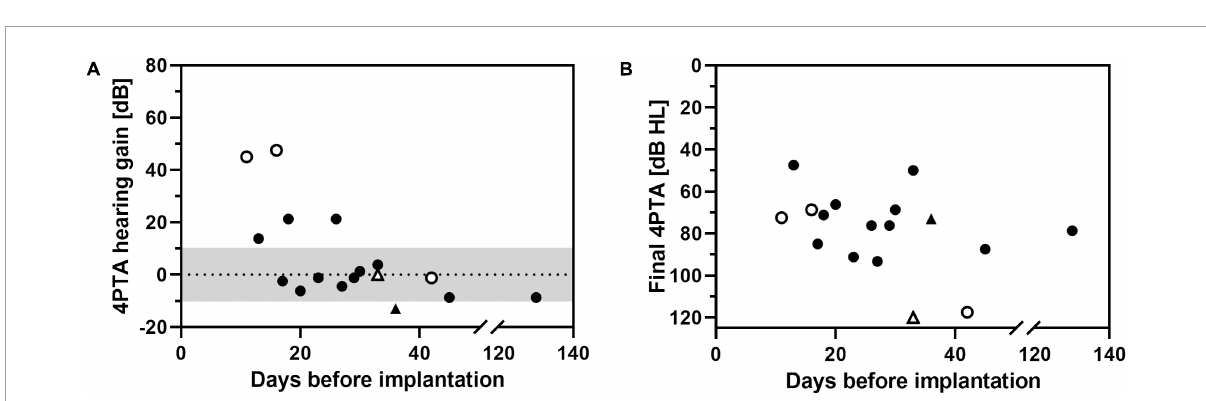
FIGURE10 Change in pure-tone average (4PTA hearing gain, A ) and final hearing threshold at follow-up 2 (final 4PTA, B ) as a function of time of implantation (days after onset of ISSHL). Triangles: intracochlear application of the drug delivery system. Open symbols: non-measurable threshold (out-of-limits) at time of